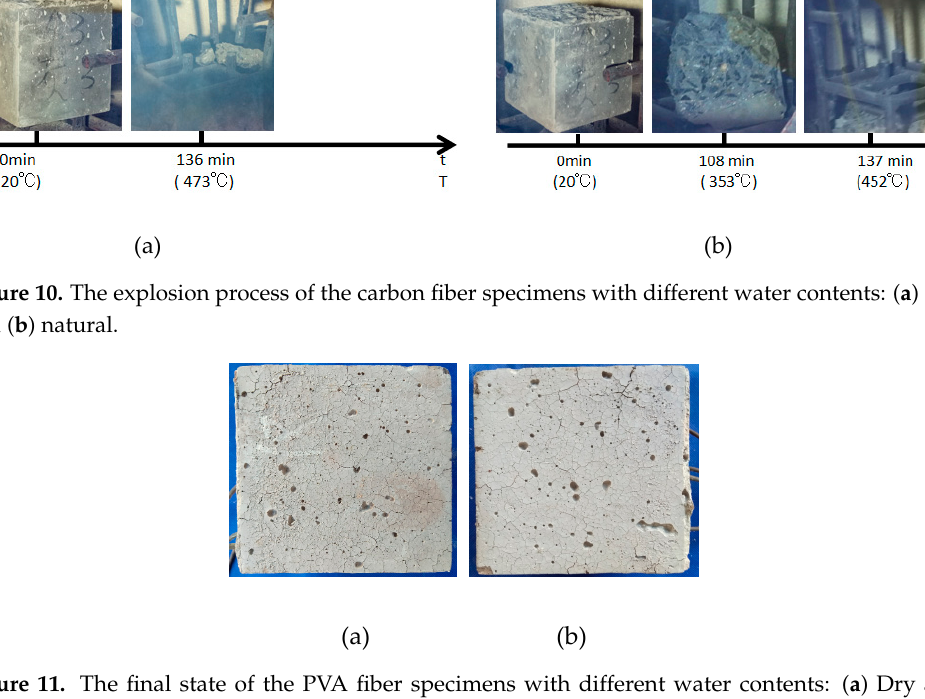
Figure 11. The final state of the PVA fiber specimens with different water contents: ( a ) Dry and ( b ) natural.